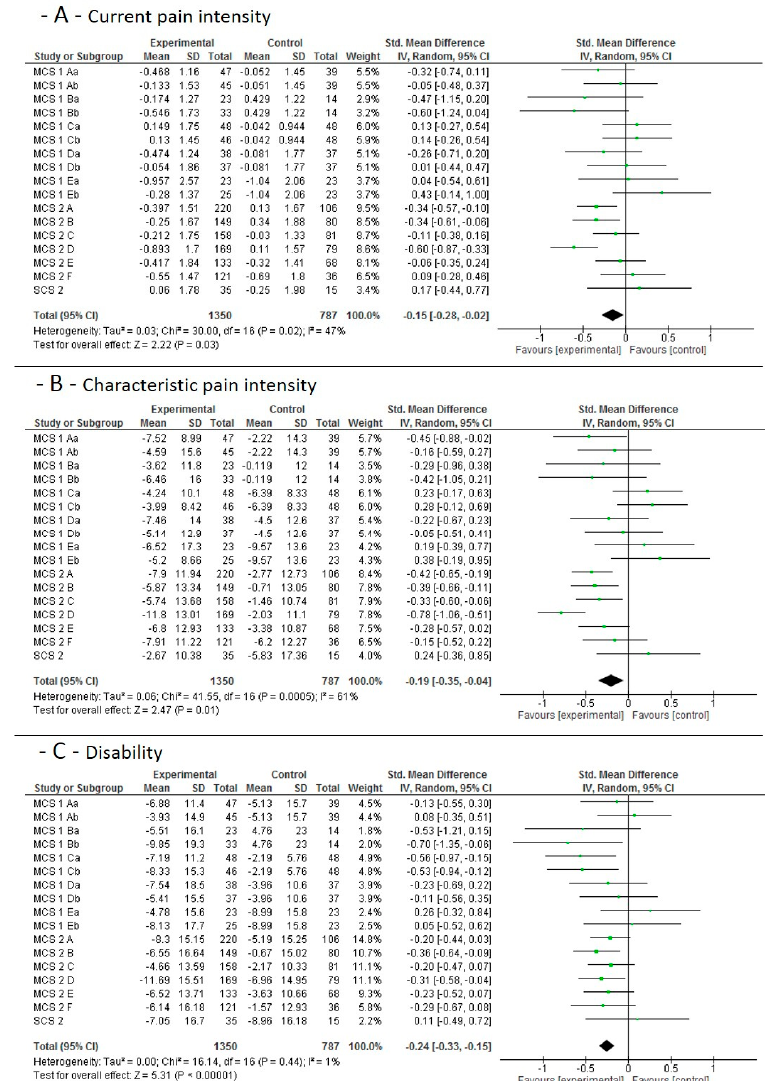
Figure 2. Data and Forest plots for the pooled outcome estimates for the short-term effects of motor control stabilisation exercise vs. no additional exercise. ( A ): current pain intensity; ( B ): characteristic pain intensity; ( C ): disability; MCS, multicenter study; SCS; single-center study; A–F are the single study sites; a stands for MCE, b for MCE + behavioral. SD, standard deviation; P, p -value; IV, inverse variance; CI, confidence intervals; experimental, motor control stabilisation group.